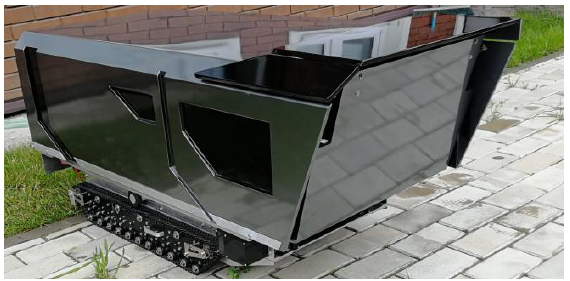
Figure 4. Mobile complex on tracked course - radius of